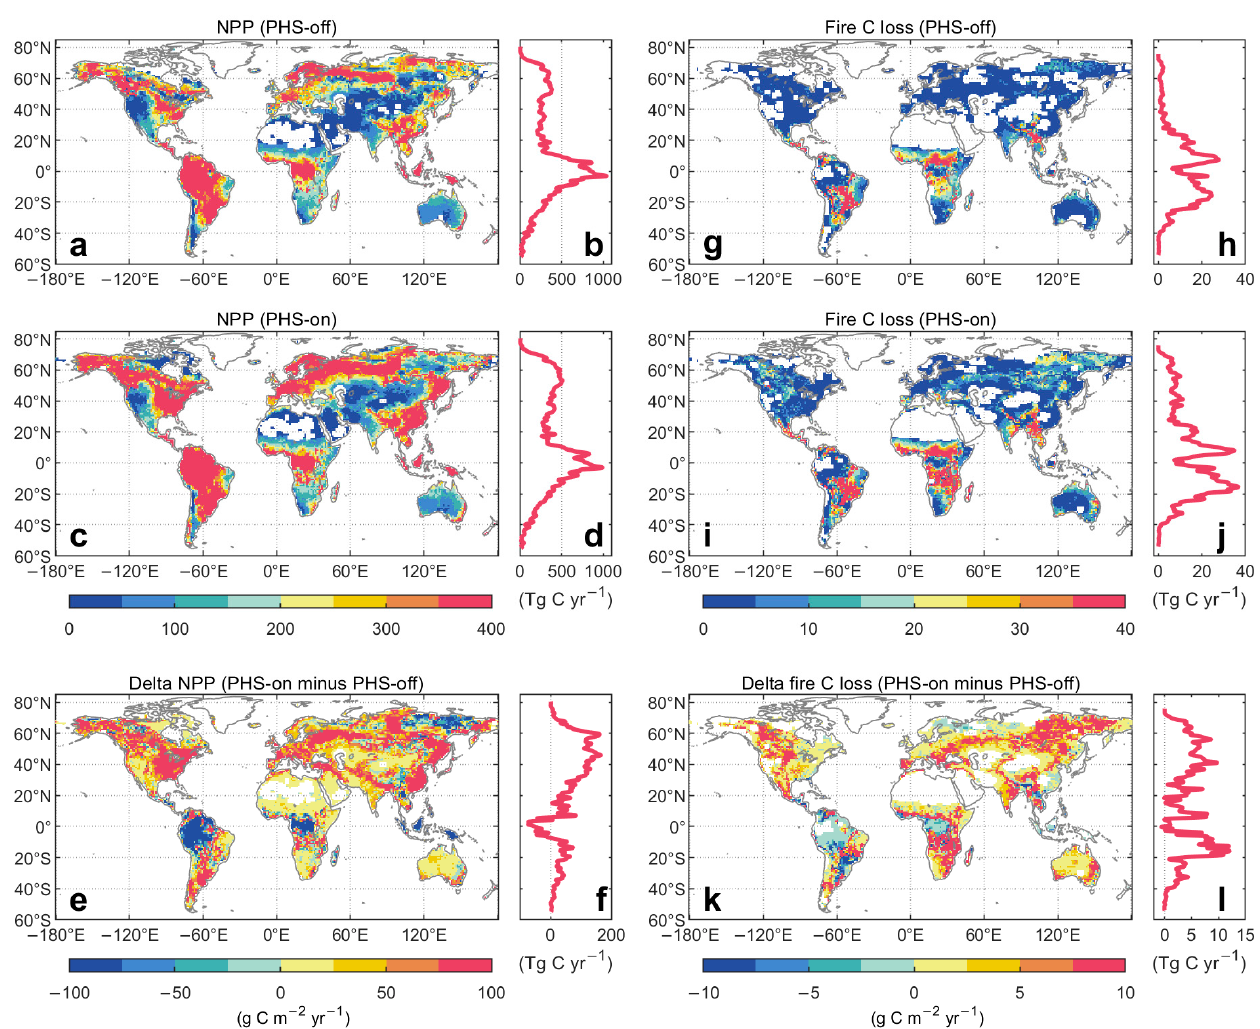
Figure 6. Spatial distributions of ecosystem net primary productivity (NPP) and fire-induced carbon (C) loss from CLM5 simulations without (PHS-off) and with PHS (PHS-on) configurations and their difference (Delta). The pixels in ( a , c , e , g , i , k ) represent temporally averaged values during 1850–2010 and the vertical thick lines in ( b , d , f , h , j , l ) represent the latitudinal mean in corresponding left panels.